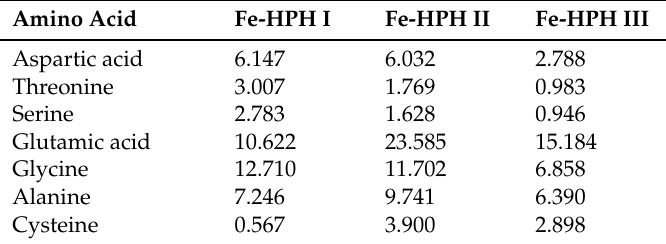
Amino acid composition of three kinds of Fe-hairtail protein hydrolysates (HPH) chelate ( µ